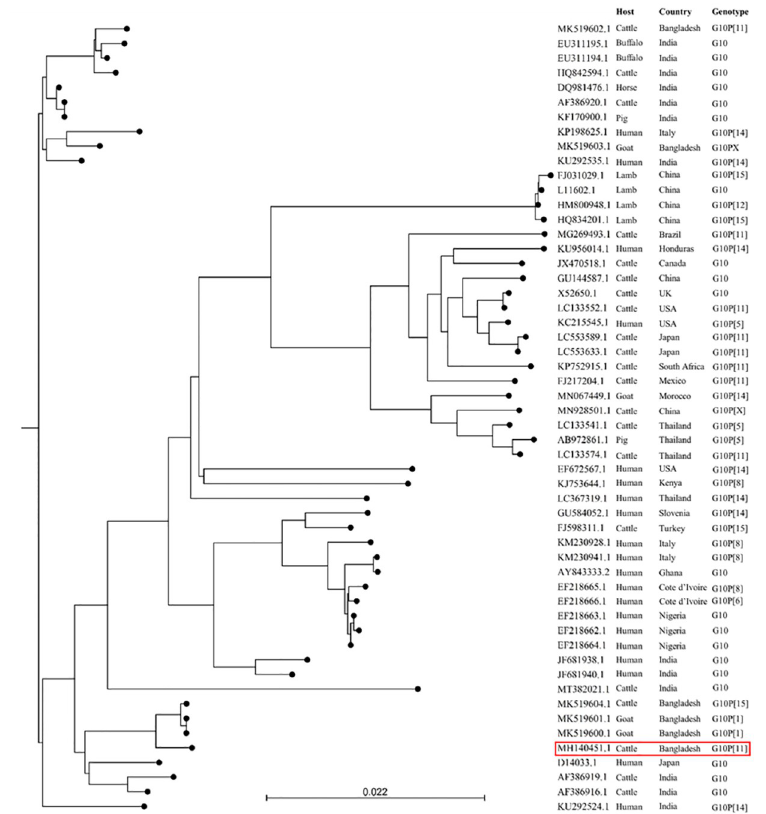
Fig 4. The evolutionary relationship of G10-VP7 genes of bovine rotaviruses detected in the present study (red rectangle). The tree was constructed with the aligned sequences downloaded through BLAST search. The relationship was inferred using the Neighbor-Joining method and the ecleotide distances were measure using Kimura 80 model on CLC Sequence viewer 8.0. The scale bar at the bottom indicates nucleotide substitutions per site.